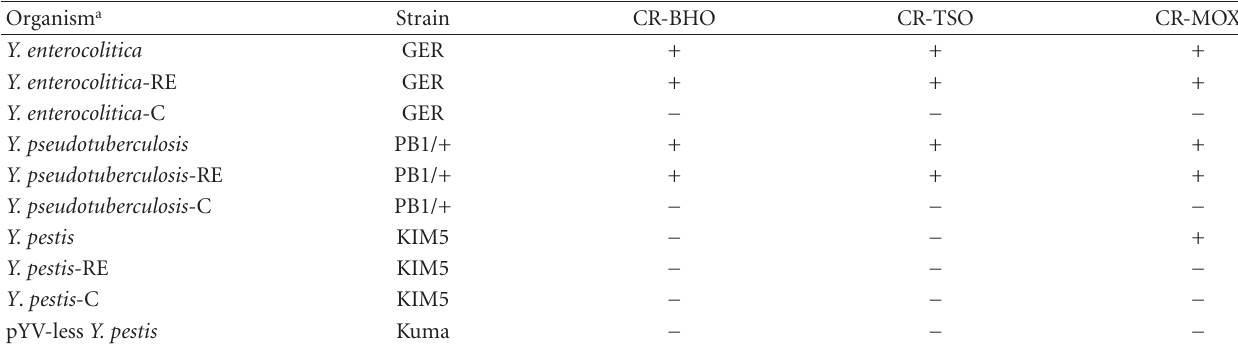
Table 2: E ff ect of media on CR-uptake in pYV-bearing Y . enterocolitica , Y . pseudotuberculosis , and Y . pestis (adapted from [7]). Organism a